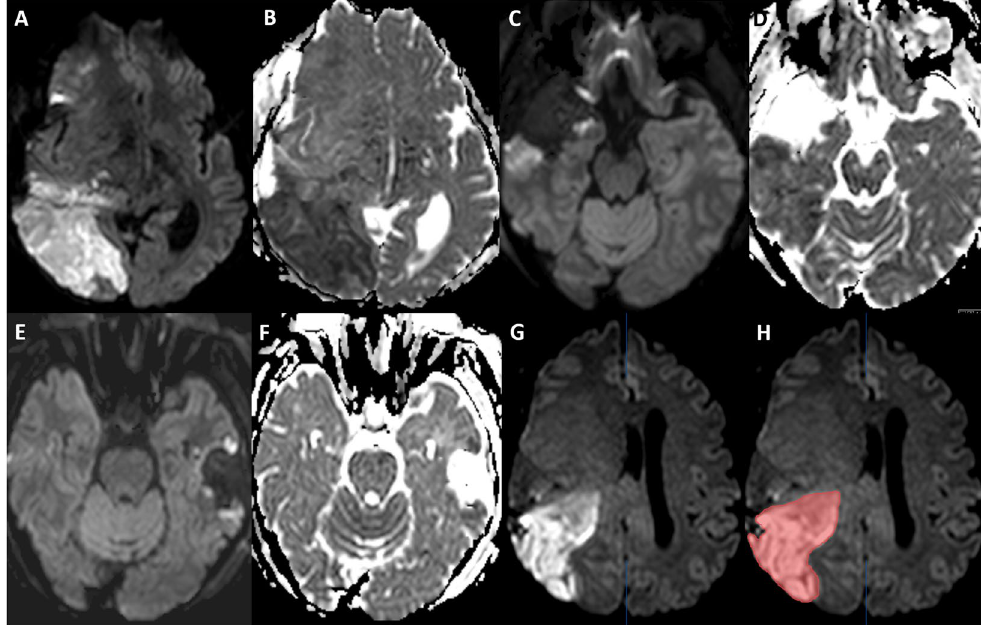
Figure 1. Examples of patients with different infarct volumes. A and B show a large infarction with hyperintensity in b-1000 images ( A ) and corresponding hypointensity in ADC ( B ). ( C and D ) show a smaller infarction at the edge of the resection cavity, while E and F show only small ischemic changes. ( G and H ) display an example of semiautomatic volumetric measurement of postoperative infarction.